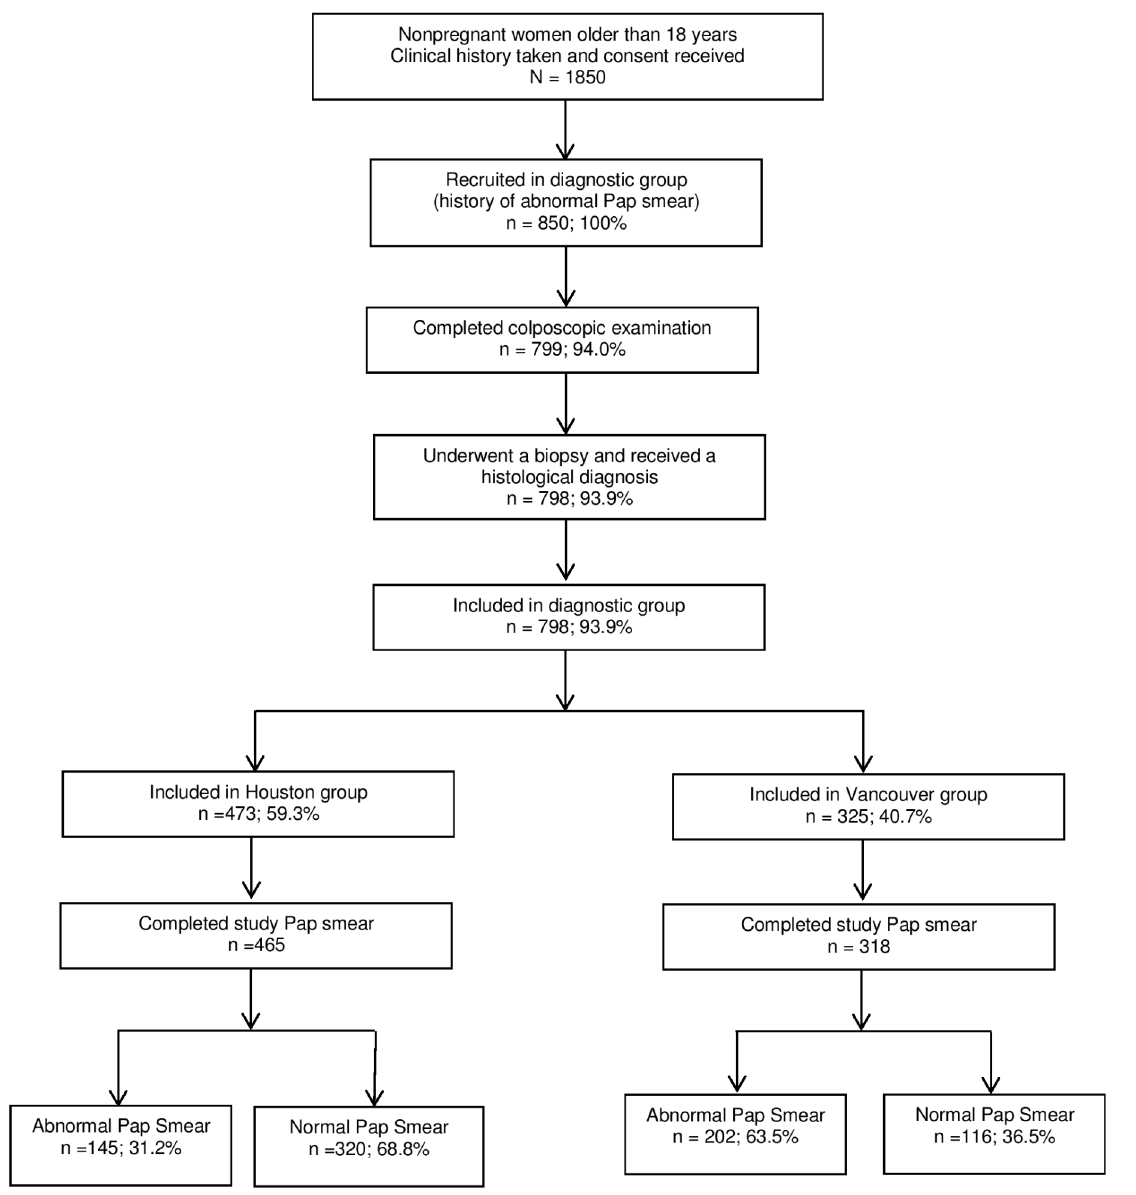
Fig 1. Patient inclusion